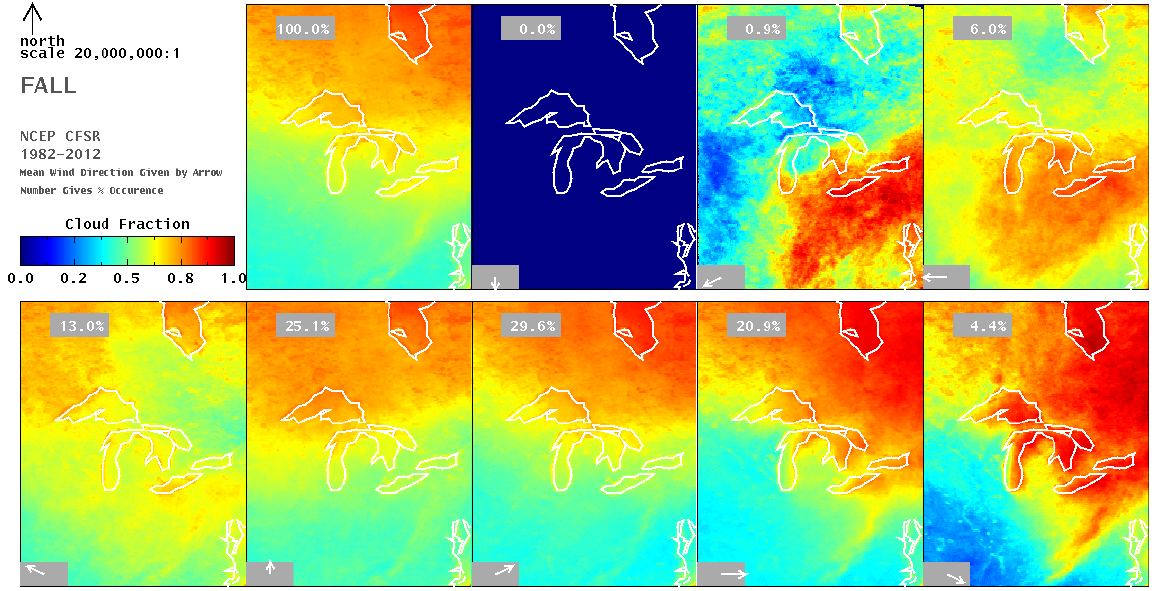
Figure 8. PATMOS-x cloud cover for the region during the 31-year time period during the autumn months (September, October, and November) composited with respect to wind direction. Same as Figure 7 except for